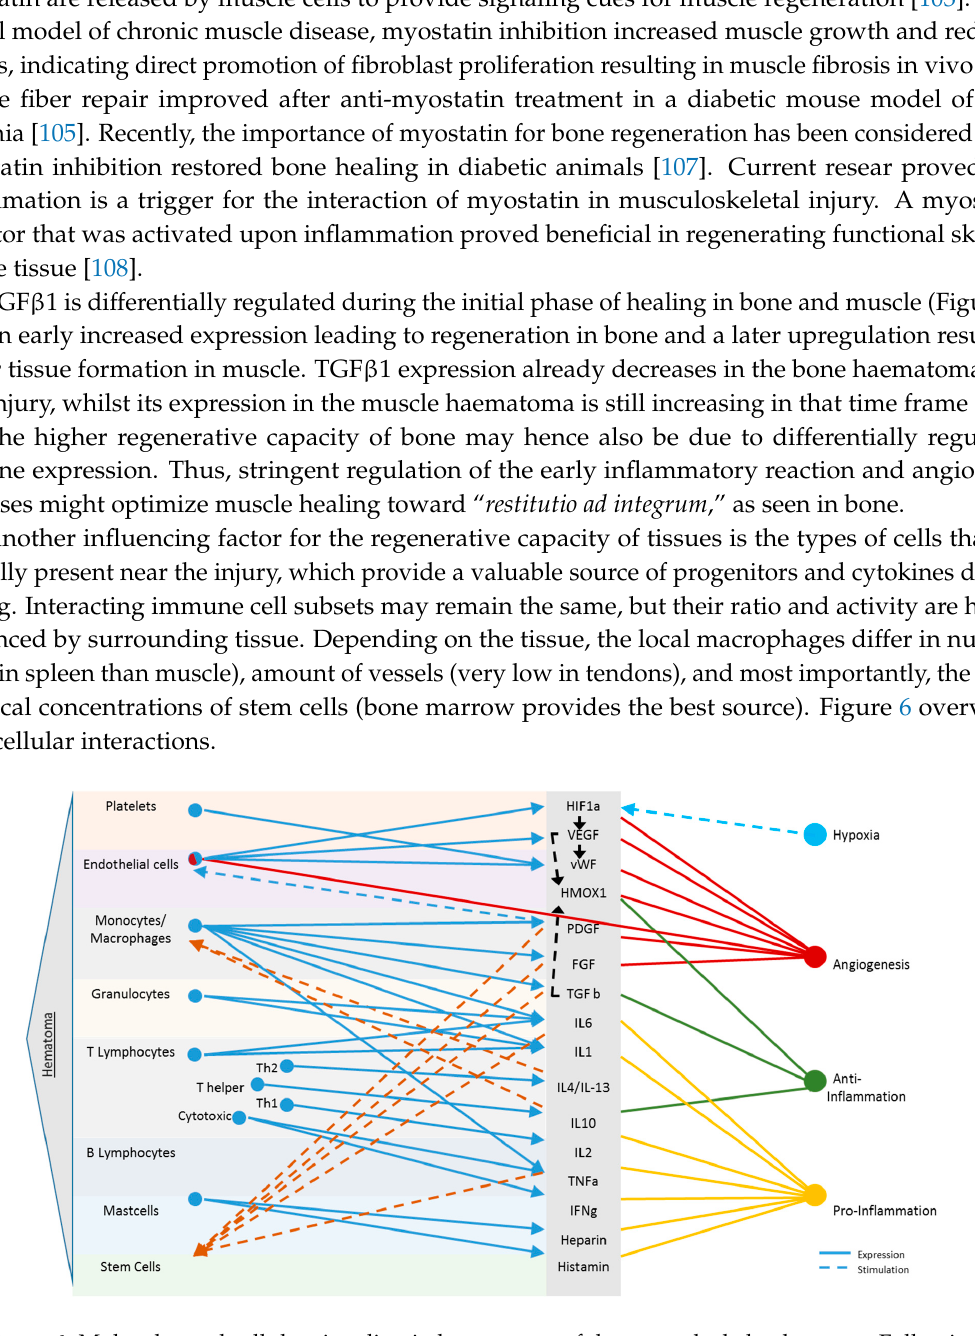
Figure 6. Molecular and cellular signaling in haematoma of the musculoskeletal system. Following each injury, upon disruption of blood vessels, haematoma formation presents the starting point of any healing process. Cells present in the musculoskeletal haematoma express a complex mixture of cytokines (solid blue lines). These are key regulators in initial regenerative processes such as hypoxia (light blue), angiogenesis (red) and inflammation (anti-inflammation: green, pro-Inflammation: yellow). The present milieu and cytokine cocktail again stimulate specific cells (e.g., stem cells, monocytes/macrophages and endothelial cells), respectively, to further promote regeneration (dashed lines). Only selected cells and cytokines present during this early healing phase are depicted